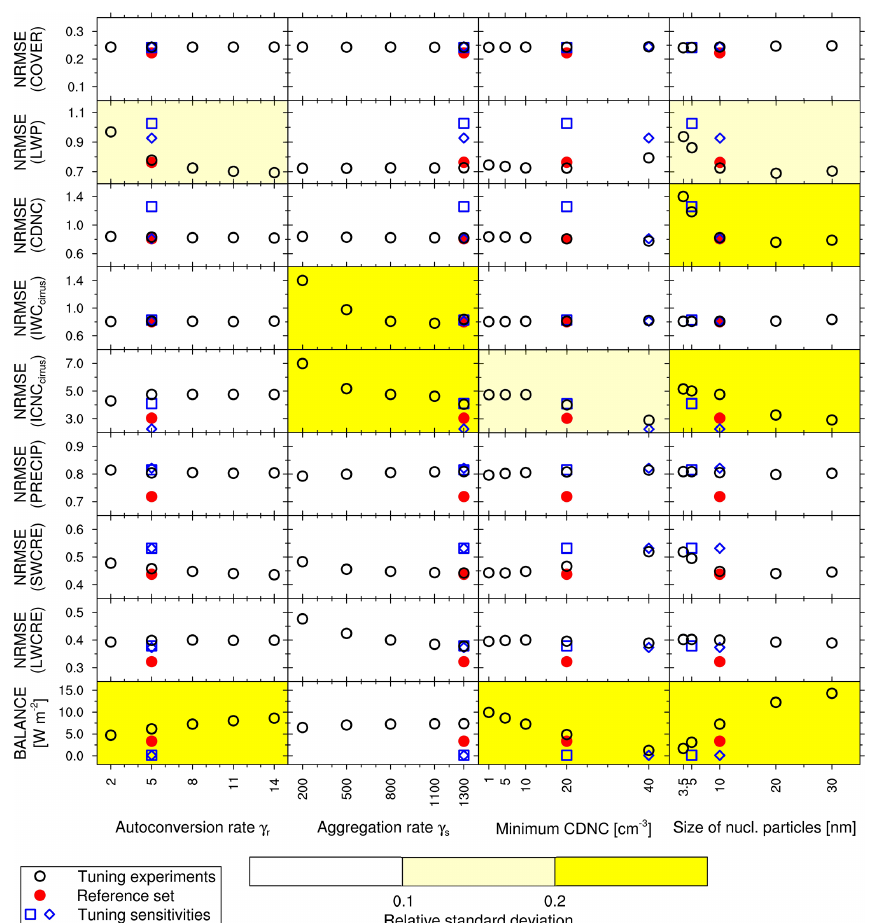
Figure 1. NRMSE of selected cloud and radiation variables in the tuning experiments, together with the resulting model top-of-the- atmosphere radiative balance (in Wm − 2 ). Each column represents a tuning parameter and shows the NRMSE for the five tuning simulations (black circles) performed to explore the effects of its variation, while keeping the others fixed at their central value (note that for the radiative balance, the actual value and not the NRMSE is shown). The red circle represents the results for the reference set of tuning parameters ( γ r = 5, γ s = 1300, CDNC min = 20cm − 3 , and d nuc = 10nm), while the blue square and diamond show the results of two additional sensitivity runs to further explore the variation on CDNC min and d nuc . The NRMSE is calculated with respect to the observations given in Table 2. The yellow shadings represent the relative standard deviation of the NRMSE within each panel. For SWCRE, the absolute value of the NRMSE is shown for more clarity (since it is negative via the